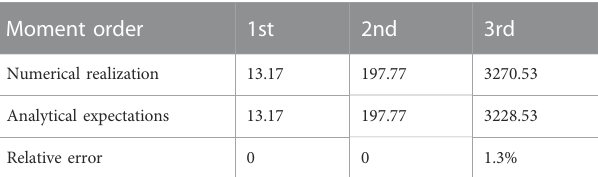
TABLE 4 Moments for a nearest-neighbor coupled network.